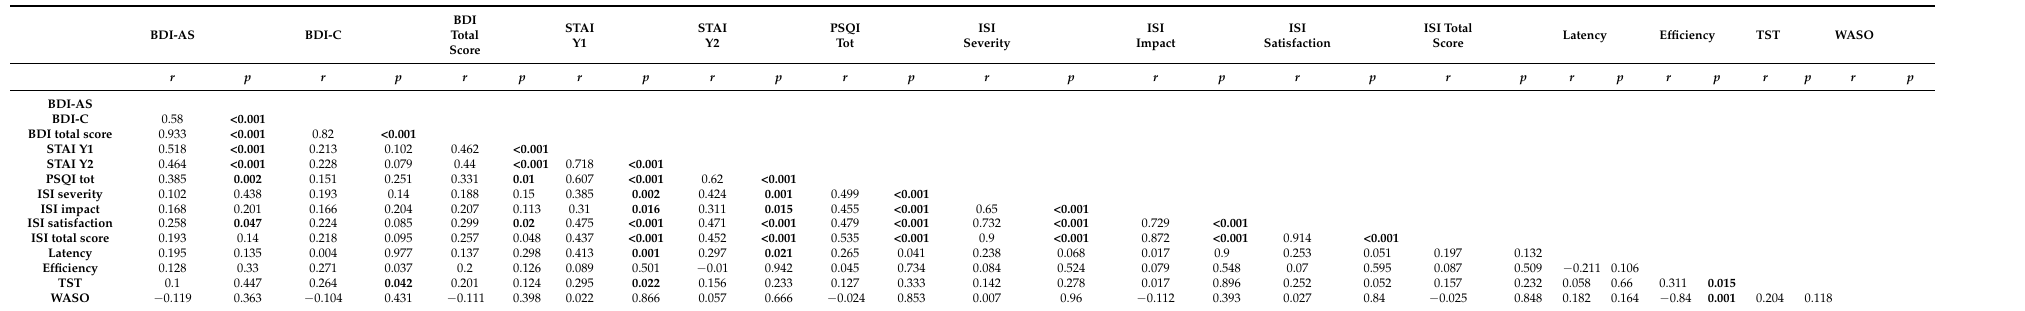
Note: STAI Y1 = State-Trait Anxiety Inventory State, STAI X2 = State-Trait Anxiety Inventory Trait, BDI-2 = Beck Depression Inventory II Edition, PSQI = Pittsburgh Sleep Quality Index, ISI = Insomnia, Severity Index, TST = Total Sleep Time, WASO = Wake After Sleep Onset. Significant correlations are indicated in